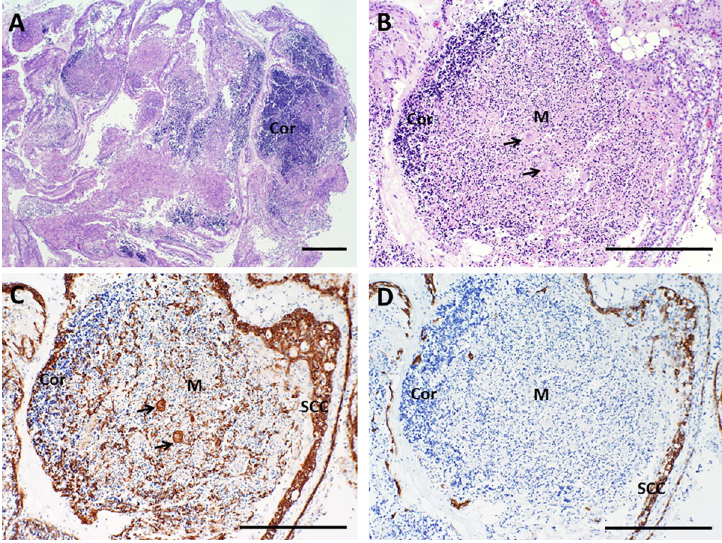
Fig 5. Architecture of cultured thymus, day 12. A, B. Hematoxylin and eosin (H&E) stain. At this time point, many thymocytes have either been lost from the tissue or they have died and their nuclei have been dissolved, making the tissue more eosinophilic (pink). Some areas retain architecture characteristic of normal uncultured thymus with cortical-like areas (Cor) that stain more basophilic (blue) and medullary-like areas (M), although with greatly decreased thymocyte cellularity. C. Pan-cytokeratin (AE1/AE3) immunoreactivity. D. Cytokeratin 14 (CK14) immunoreactivity. Brown color indicates a positive reaction with antibody. At this time point, the sub-capsular cortex (SCC) has thickened and epithelial cells appear more prominent due to the decreased numbers of thymocytes present. Arrows point to representative Hassall bodies. Bar represents 1 mm in A and 500 μ m in